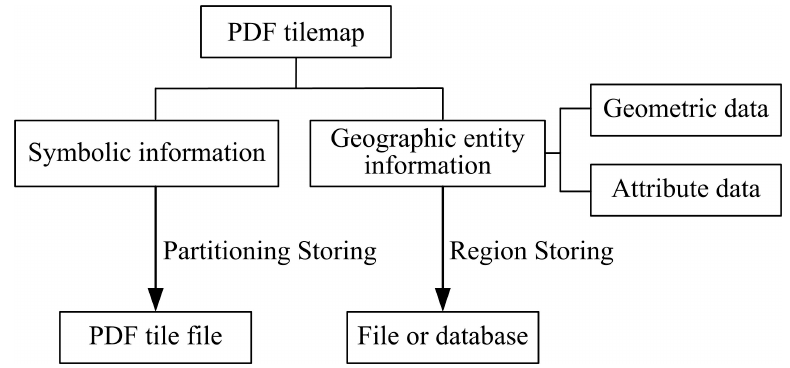
Figure 4. PDF tile map components.